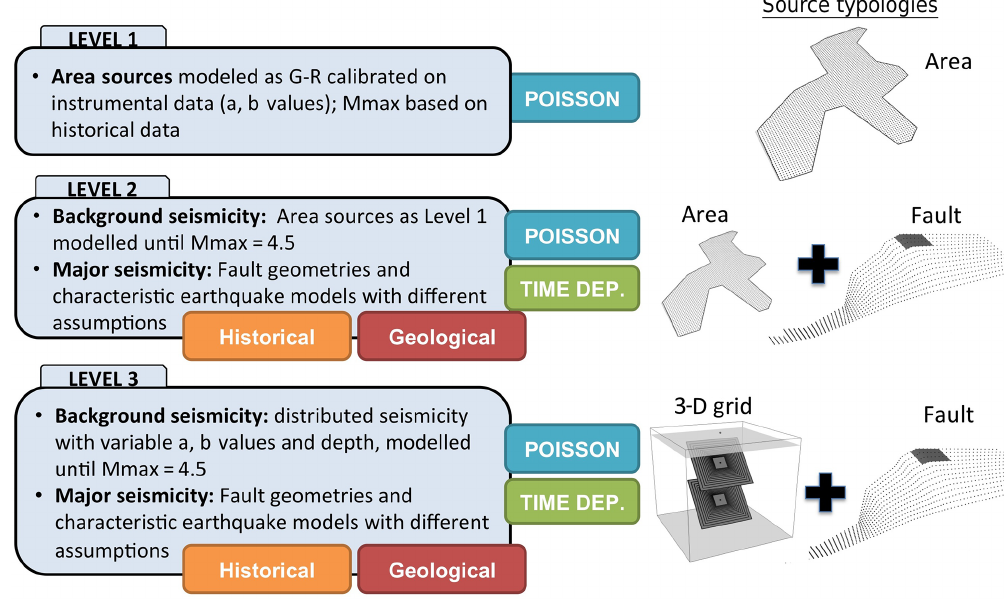
Figure 2. Schematic chart describing the three branching levels of the source model and depiction of the different source typologies used for modeling. The major seismicity of levels 2 and 3 is modeled using fault sources, where seismicity rates are derived using historical and geological approaches, considering both time independence (Poisson) and time